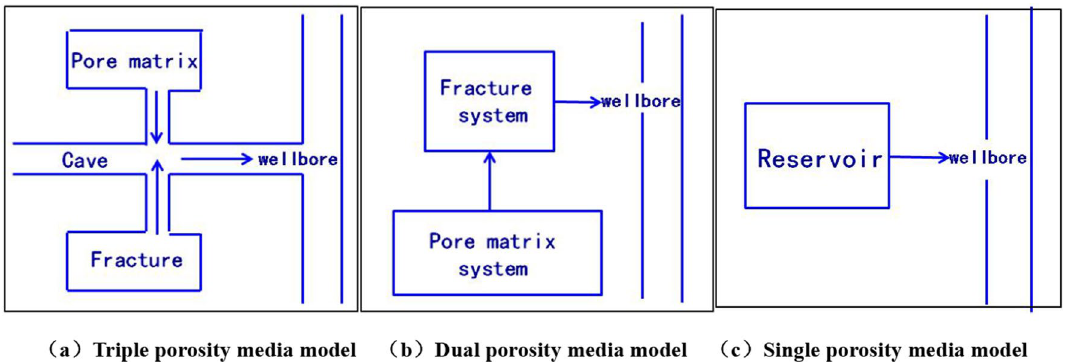
Fig. 2 Flow pattern hypothesis